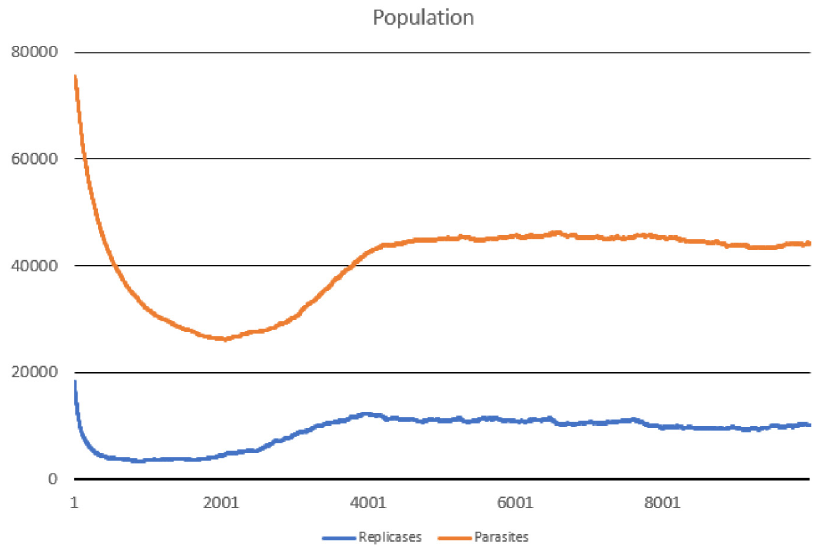
Fig 5. Population of parasites and replicases in Scenario 2.